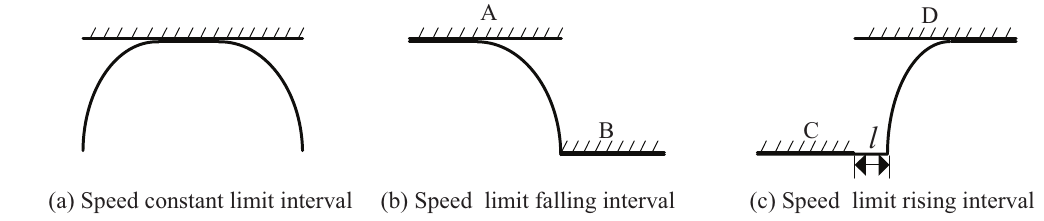
Figure 1. The processing of three speed limit sub-intervals: ( a ) Speed constant limit interval; ( b ) Speed limit falling interval; ( c ) Speed limit rising